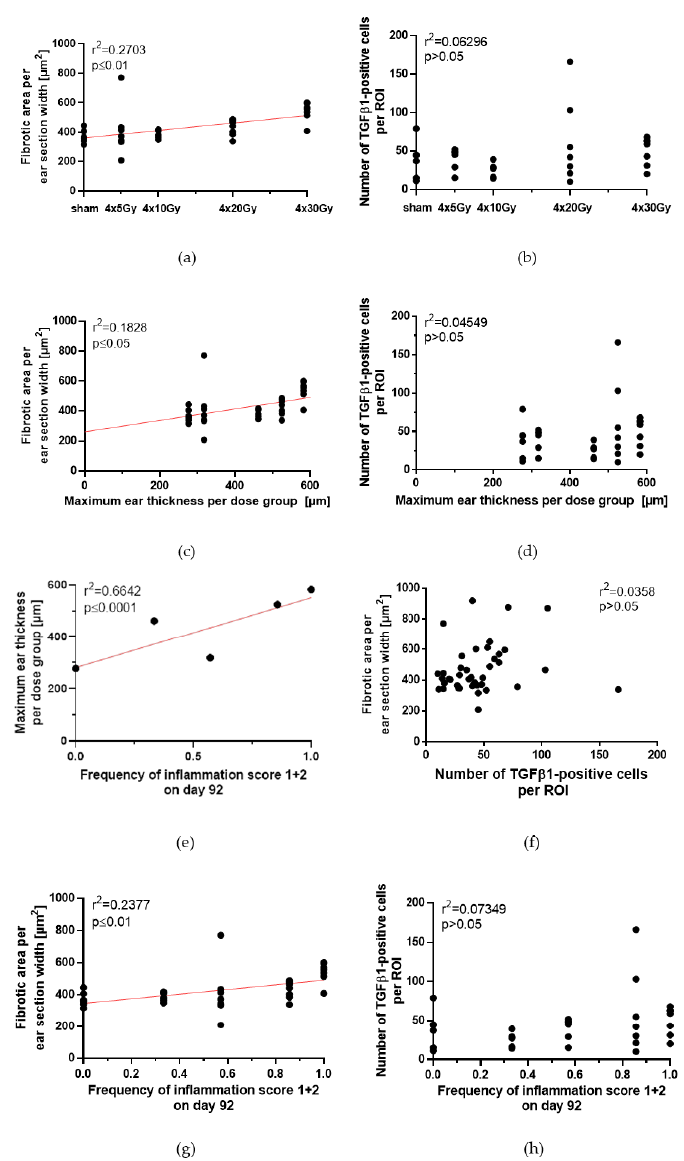
Figure 8. Immunohistochemical detection of TGF β1 (brown color) in mouse ear sections on day 92 following hypofractionation with different doses per fraction: sham ( A ), 5 Gy ( B ), 10 Gy ( C ), 20 Gy ( D ), 30 Gy ( E ). Positive endothelial and intravascular inflammatory cells are indicated by arrowheads, epidermal immunoreactivity by closed arrows, and immunoreactivity of dermal cells by open arrows. Paraffin sections of murine ears are shown. Chromogenic substrate: diaminobenzidine (DAB), nuclear counterstain: hematoxylin. Scale bar: 200 µm (for zoom-in image 20 µm).